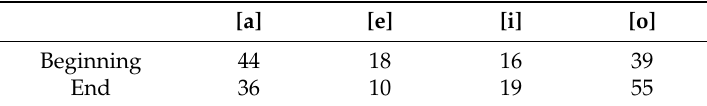
Table A6. Token counts for vowel formant measurements used to assess changes in individual vowel production by Informant B in Section 4.2.2.